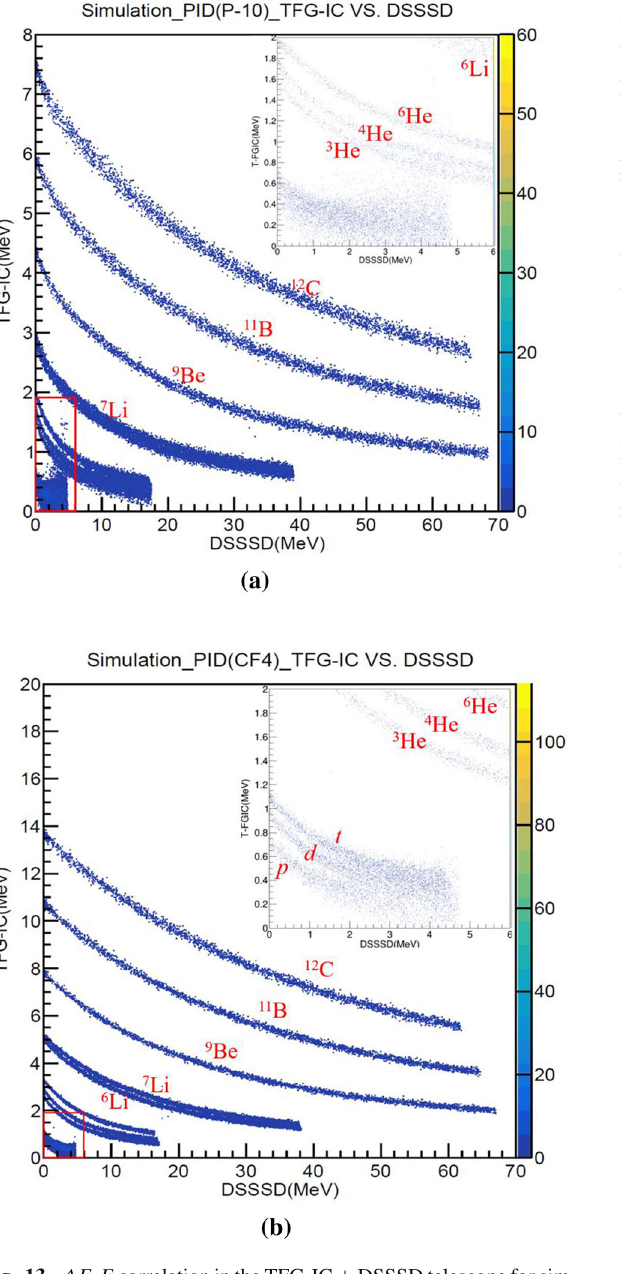
technique using TFG-IC. This method will extend the iso- topic identification to heavier nuclear-reaction